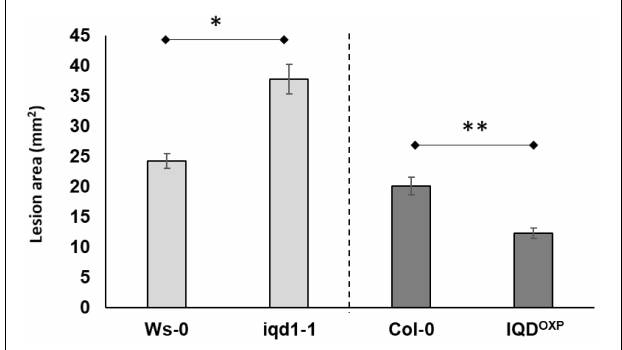
FIGURE 1 | Pathogenicity of B. cinerea to Arabidopsis plants. Shown are averages of lesion size (mm 2 ) of B. cinerea (Grape) on parental WT plants ( Ws-0 or Col-0 ), on an IQD1 knockout line iqd1 -1 and the over expressor line IQD1 OXP 72 h post-inoculation. Each column represents an average of 20 leaves, with standard error bars indicated. Asterisks above the columns indicate statistically significant differences at P < 0.05 from the corresponding WT, as determined using Student’s t- test. Results shown are from a biological replicate representative of six independent experiments.